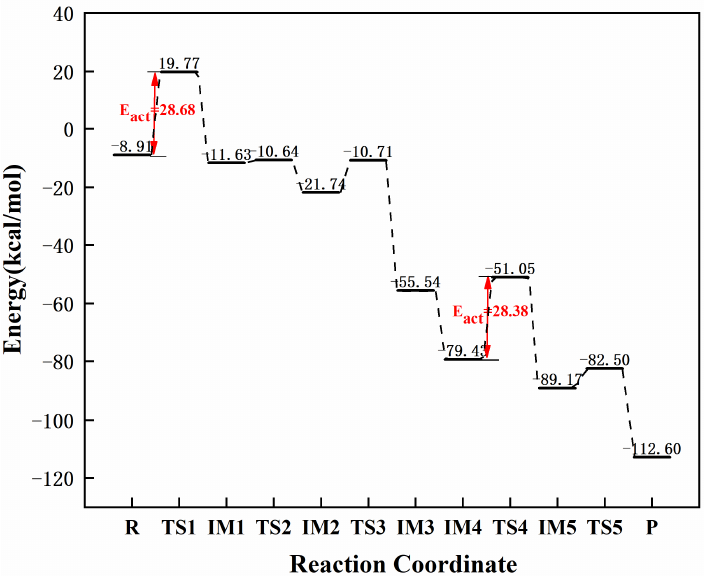
Figure 6. The most favorable energy path diagram for the hydrogenation of acetylene on graphene- NiN 1